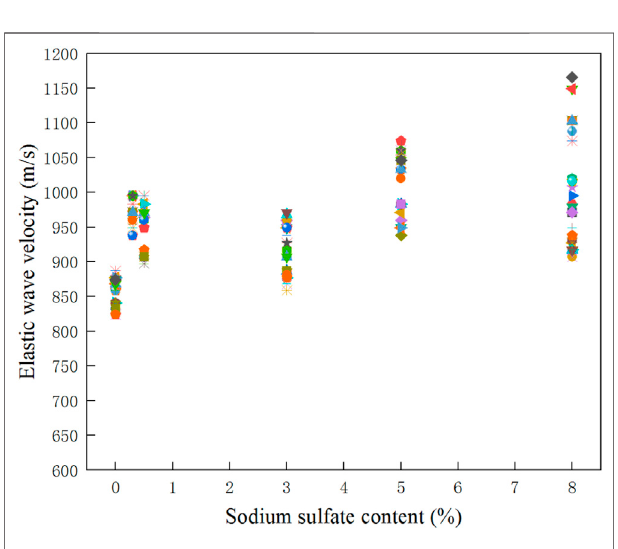
FIGURE 8 | Elastic wave velocity of sulfate soil with different sulfate